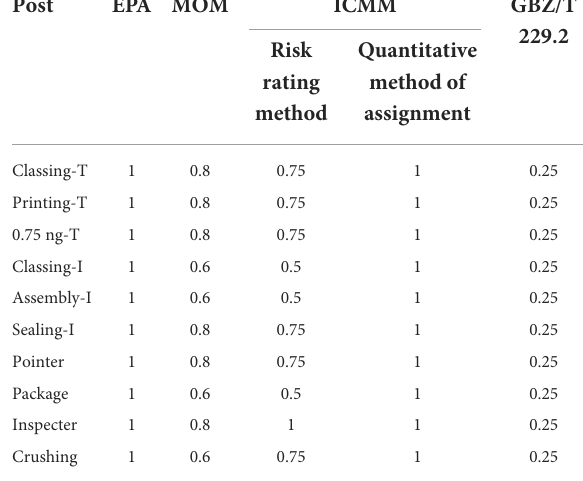
TABLE 6 RRs of exposure to mercury at each position in 2019. TABLE 7 RRs of exposure to mercury at each position in 2020.